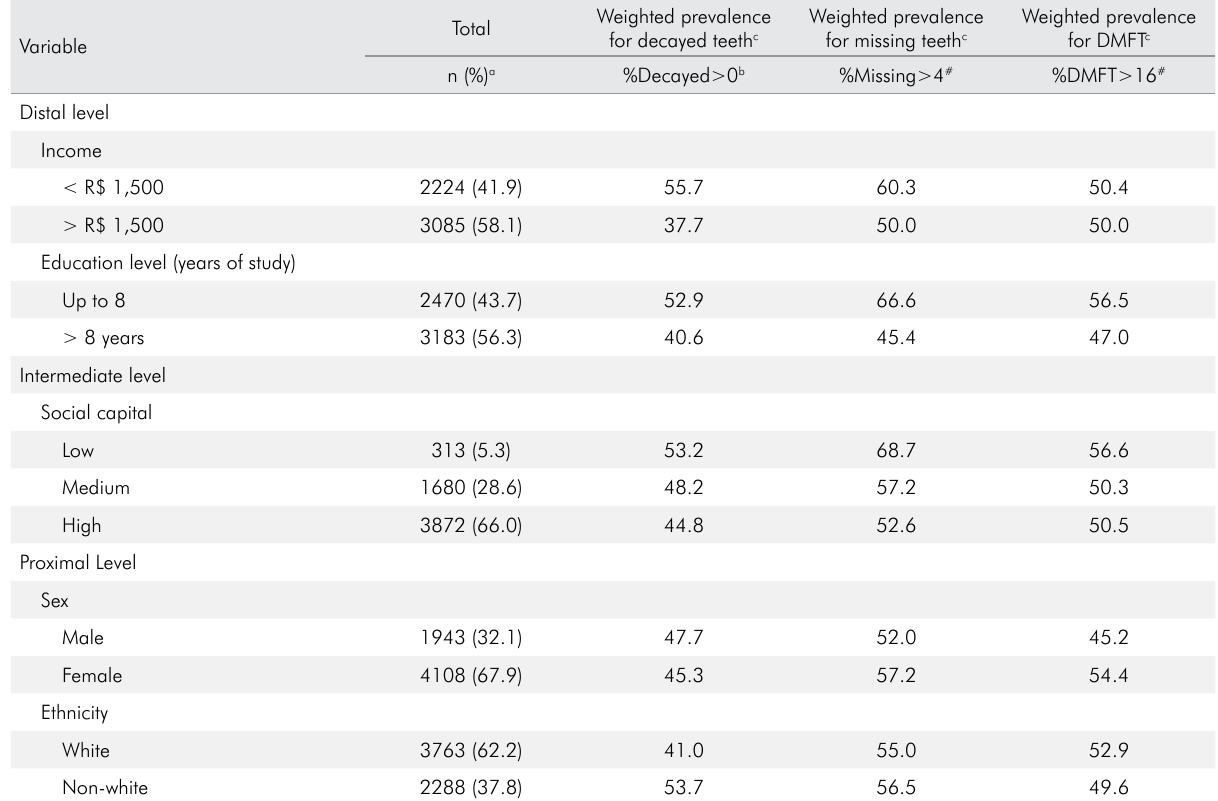
Table 2. Frequency distribution and weighted prevalence for the number of decayed and missing teeth, and DMFT regarding the variables